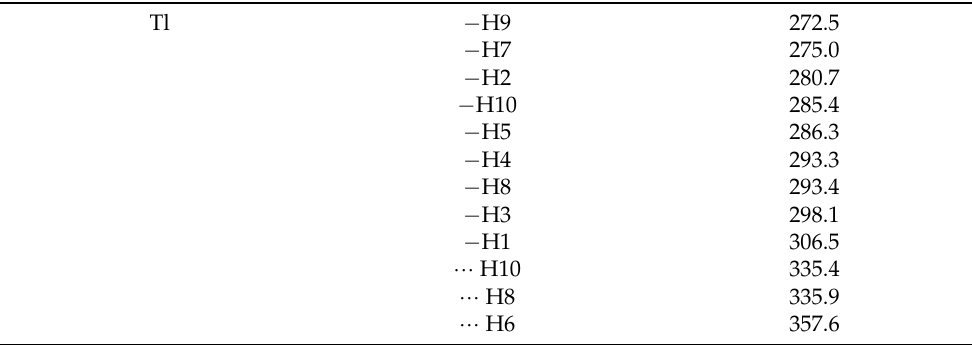
Table 4. Distances ( d /pm) between the Tl + cations and coordinatively relevant hydrogen atoms of the [CB 11 H 12 ] − anions in Tl[CB 11 H 12 ] up to 400